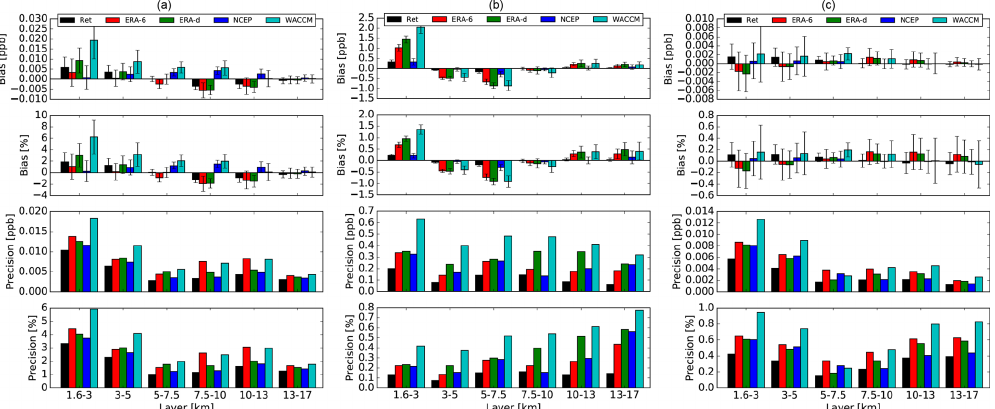
Figure 12. Statistical analysis results (bias and precision) for HCN (a) , CO (b) , and C 2 H 6 (c) using different WV profiles at different altitudes. The error bars in the bias represent the standard error of the